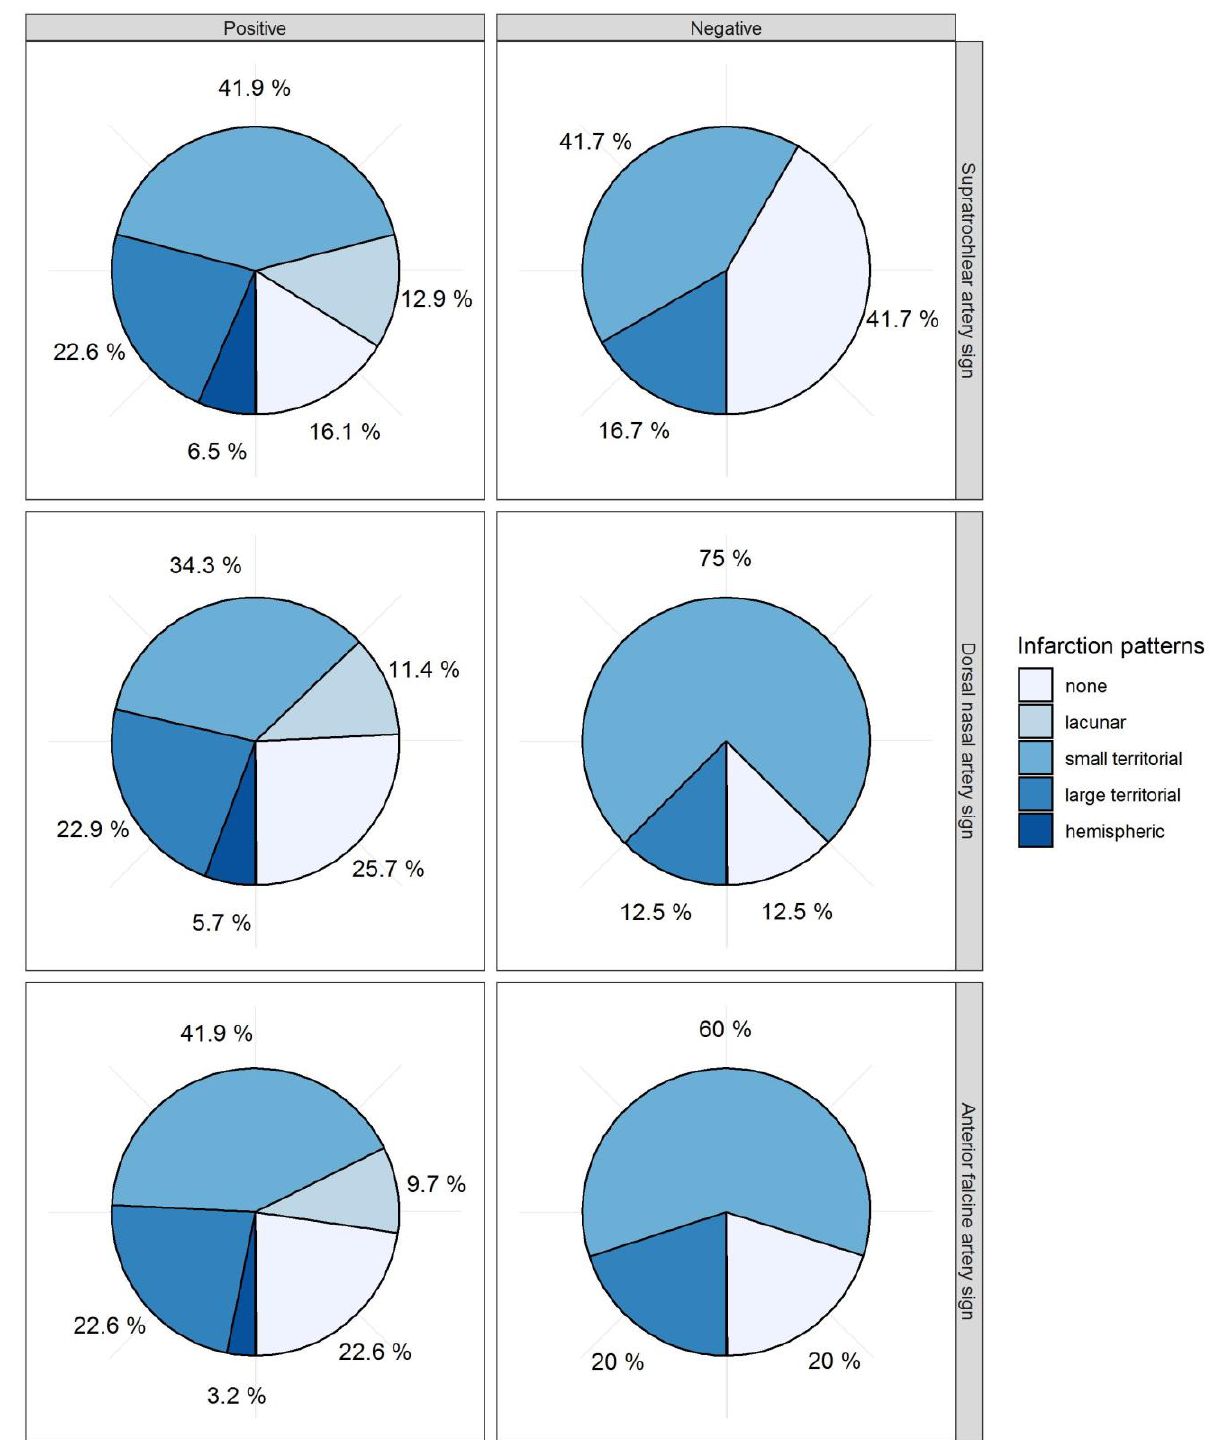
Figure 4. Infarction pattern. The distribution of infarction size is displayed in circle diagrams for each positive and negative vessel sign. Supratrochlear artery (STA) sign: positive n = 31 (72.1%), negative n = 12 (27.9%). Dorsal nasal artery (DNA) sign: positive n = 35 (81.4%), negative = 18.6%. Anterior falcine artery (AFA) sign: positive n = 31 (72.1%), negative n = 5 (11.6%). Eight cases were dropped out due to AFA sign, if the forehead was incompletely depicted (18.6%).